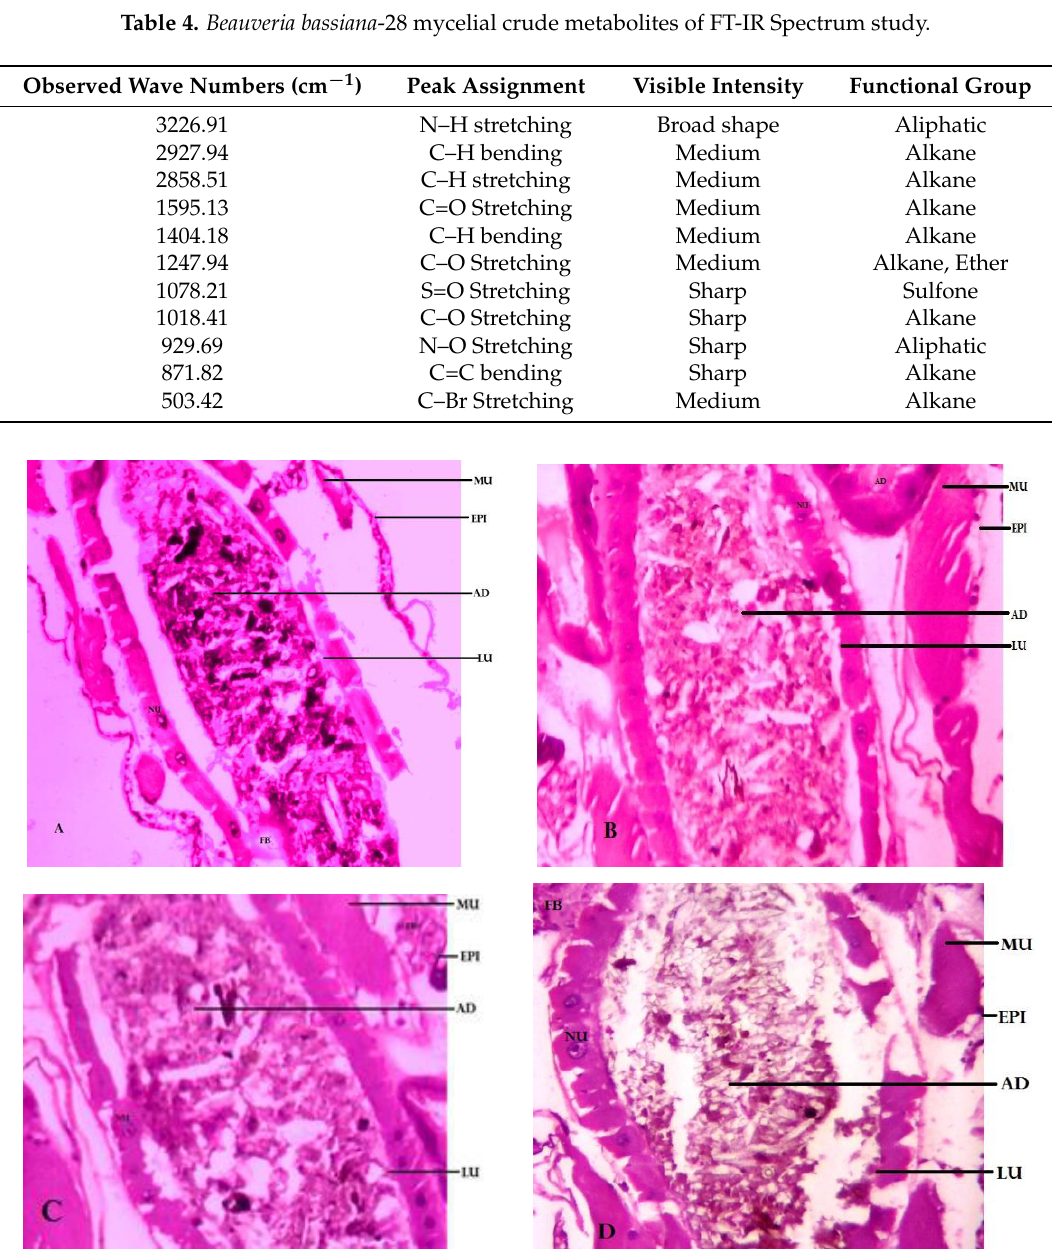
Table 4. Beauveria bassiana -28 mycelial crude metabolites of FT-IR Spectrum study.